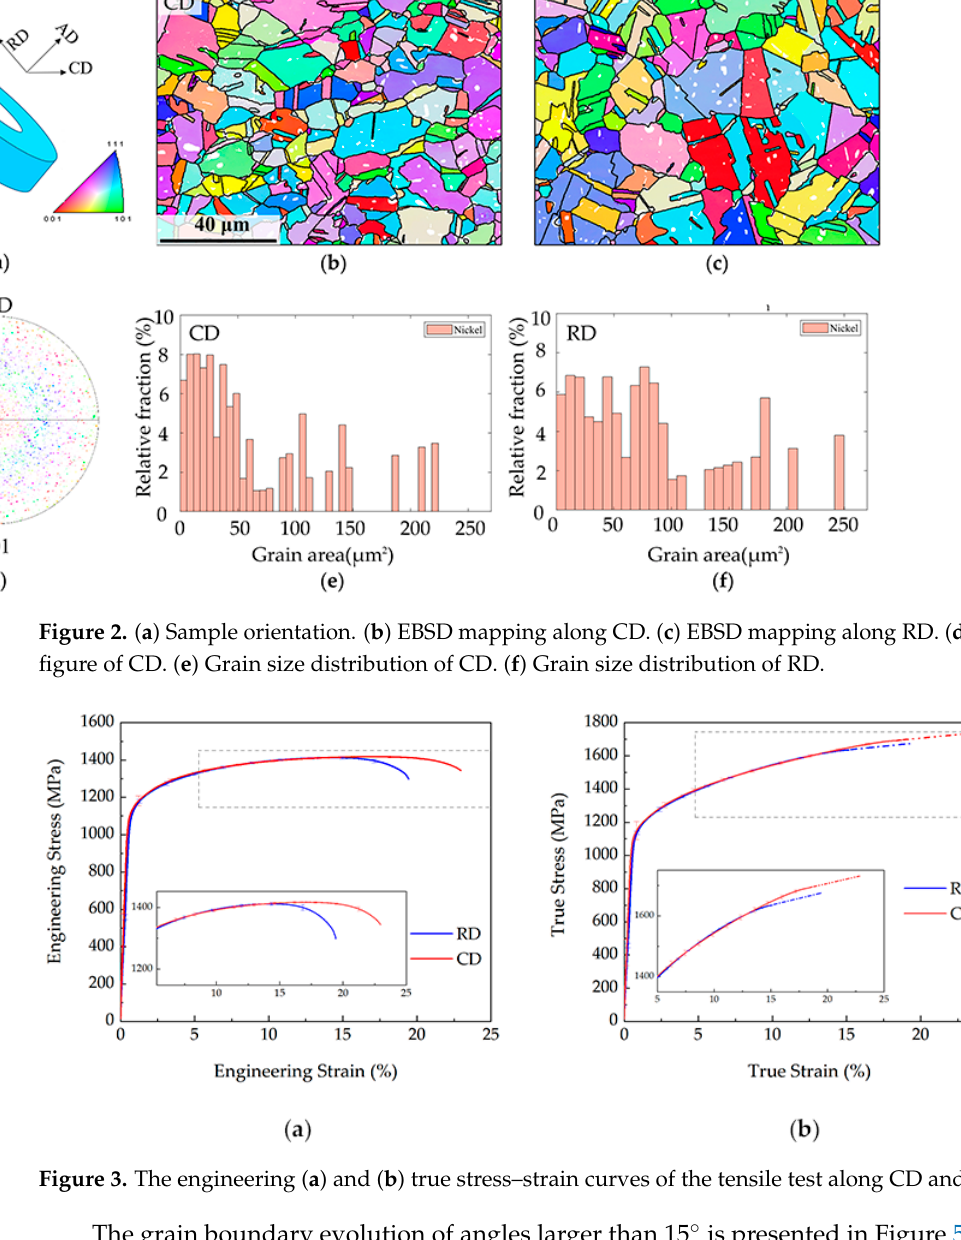
Figure 3. The engineering ( a ) and ( b ) true stress–strain curves of the tensile test along CD and RD.